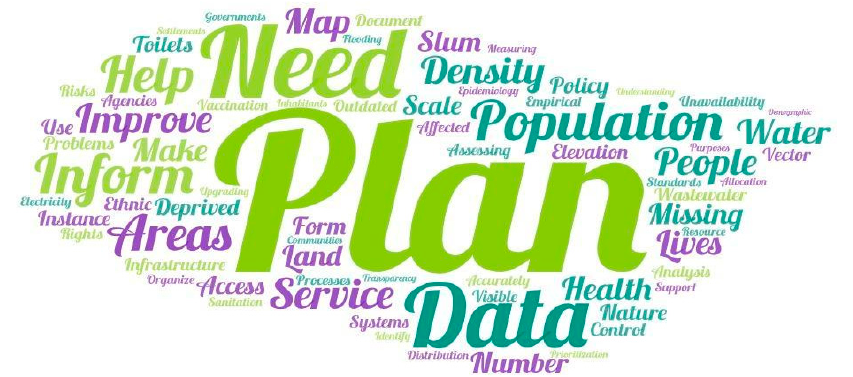
Figure 8. Word cloud of participants of several workshops (using Mentimeter) asking for reasons why deprived area related data are needed.